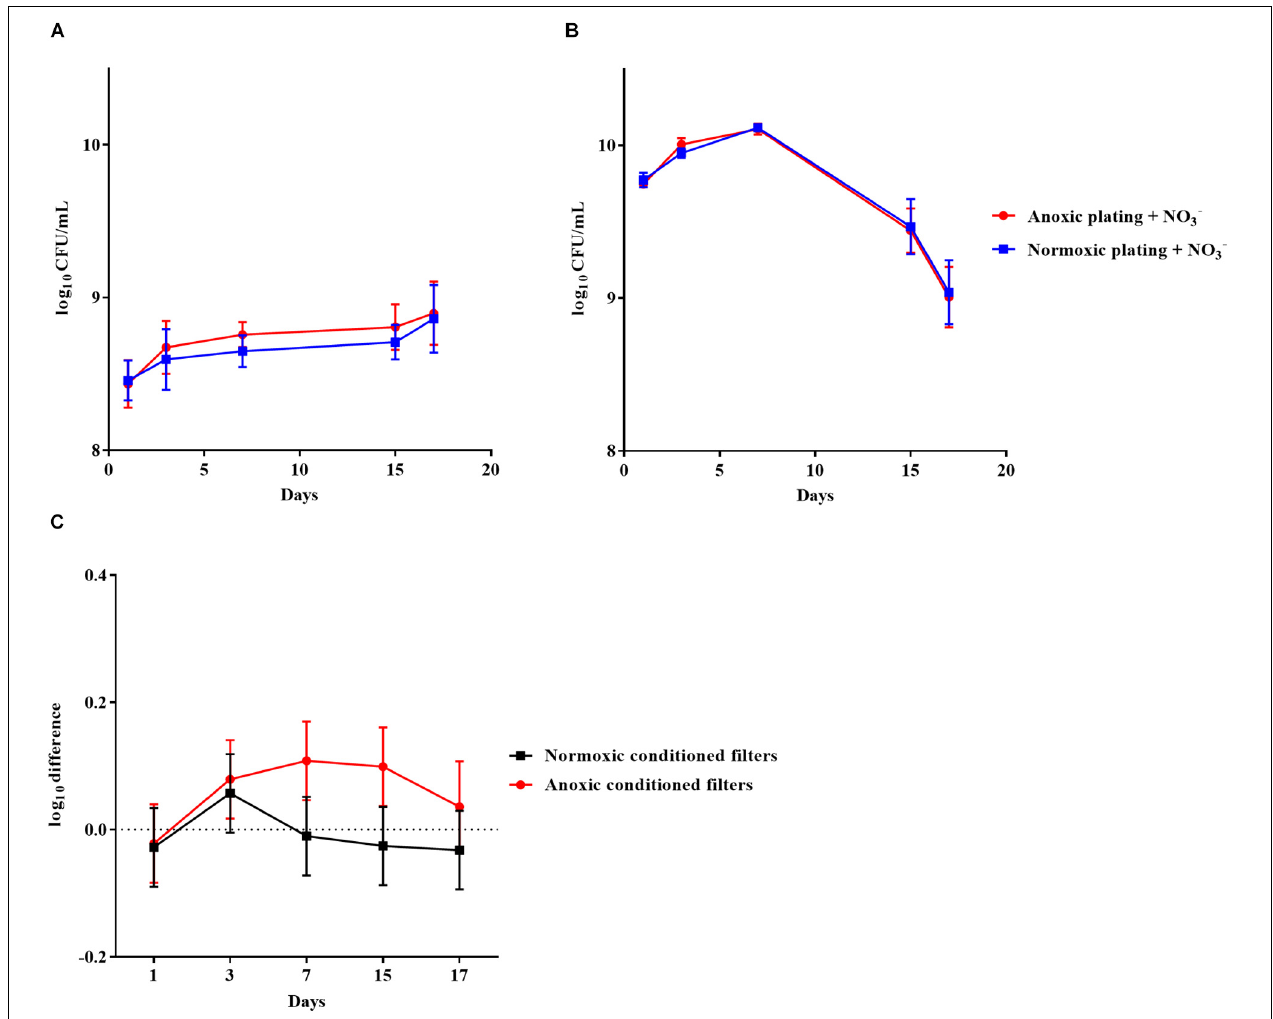
FIGURE 3 | An oxygen intolerant subpopulation of Pseudomonas aeruginosa (PAO1) was generated in the filter biofilm model. Normoxic and anoxic colony forming units per milliliter (CFU/mL) of PAO1 over 17 days from anoxically (A) and normoxically (B) conditioned filters. Symbols with error bars indicate the mean ± SEM ( n = 4). +NO 3 - refers to the addition of 10 mM KNO 3 to LB agar plates. The log difference (C) represents the difference in mean log CFU/mL between plating methods from the normoxically and anoxically conditioned filters, respectively. The log difference was significantly higher ( p = 0.01, linear regression) in the anoxically conditioned filters than the normoxically conditioned. Symbols with error bars indicate the mean + confidence